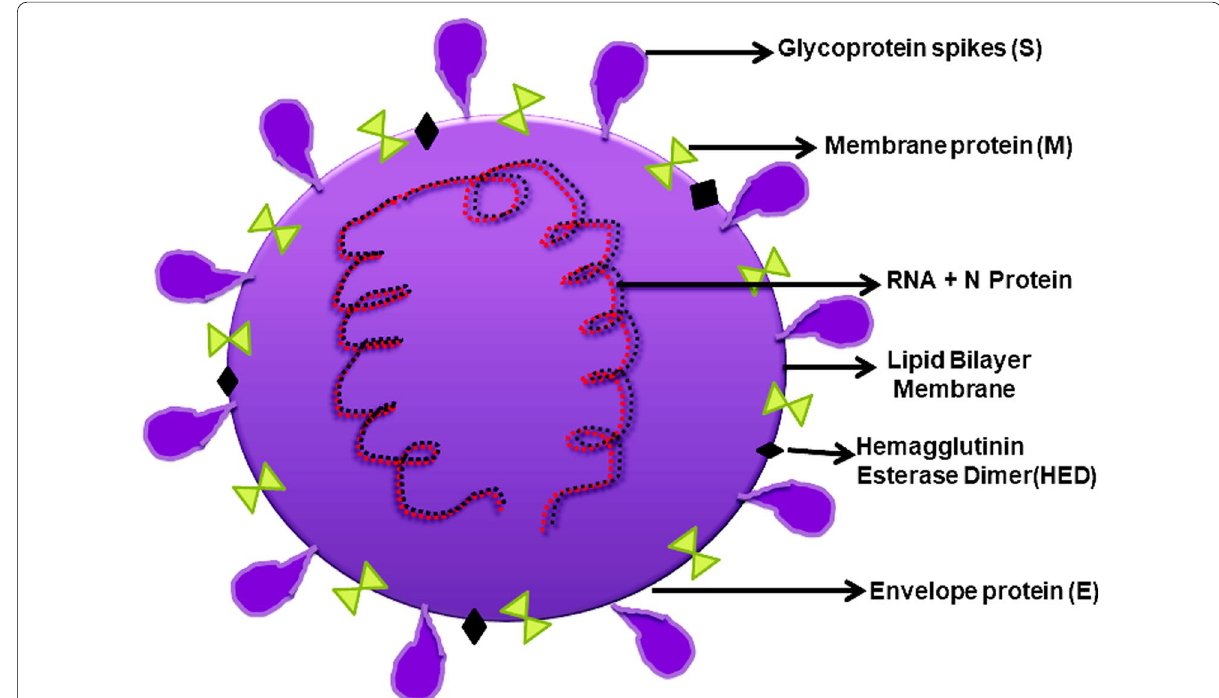
Fig. 2 Structural information of